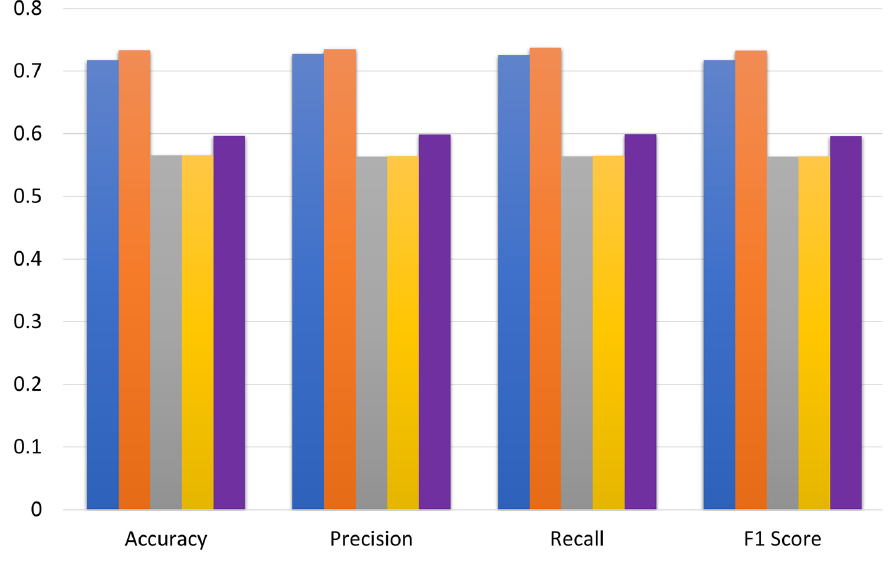
Figure 2. Model comparison for different techniques based on current admission scores (ASC).